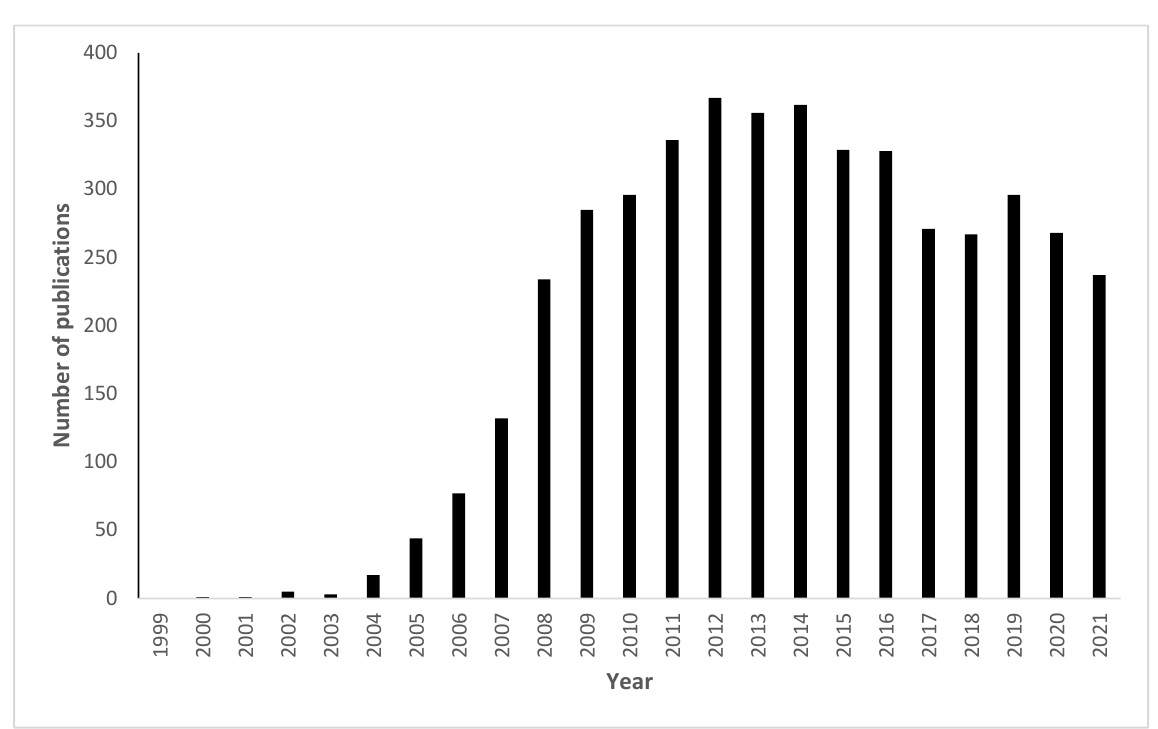
Google S cholar search engine. In the search engine, the following keyword was used “ click chemis-